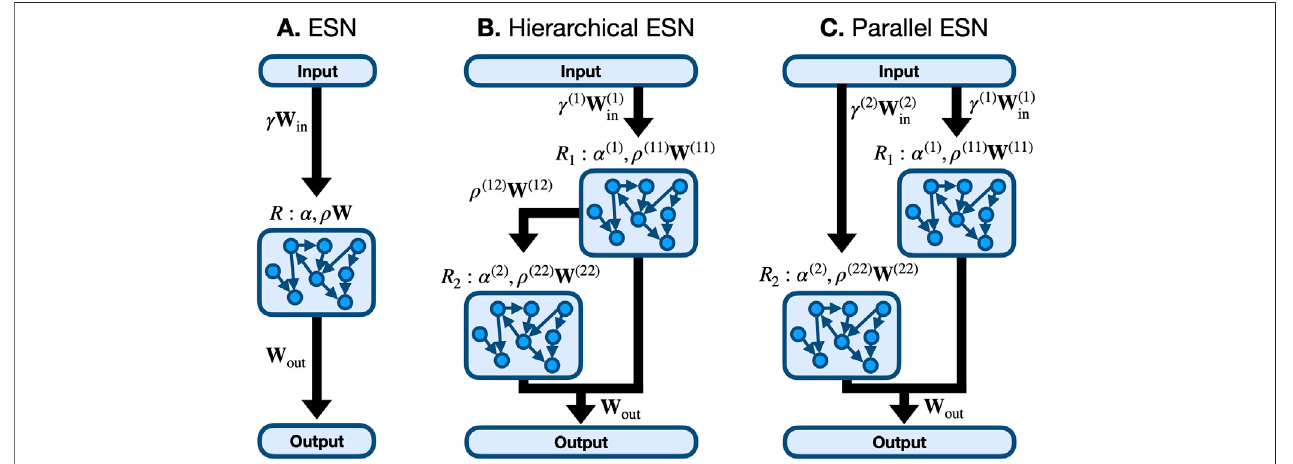
FIGURE2| Singleandhierarchicalecho-statenetwork(ESN)architectures. (A) :AsingleESNwithinternallyconnectednodeswithasinglesetofhyper-parameters α and ρ . (B) : A hierarchical ESN composed of 2 connected reservoirs where the input is fed into reservoir one only and the connection is unidirectional from R1 to R2, which is identical to the 2 layer DeepESN of [27]. (C) : A parallel (or unconnected hierarchical) ESN where the network is partitioned into 2 reservoirs, R1 and R2, which each receive the input and provide output but have distinct